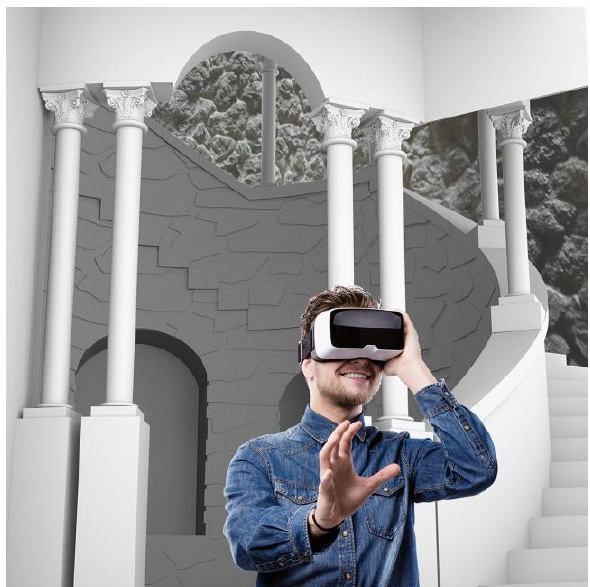
Figure 16 . The Quinta da Regaleira in Sintra, the Poço Iniciatico , digital visualisation in AR for remote use of